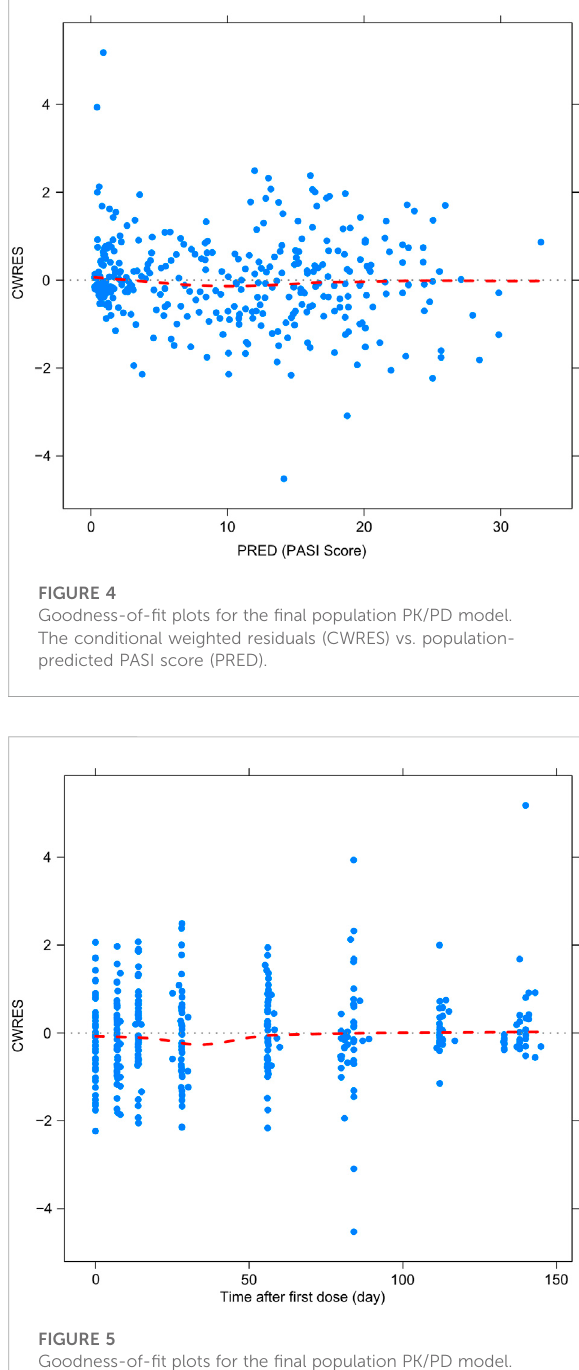
FIGURE 3 Goodness-of- fi t plots for the fi nal population PK/PD model. Observed PASI score (DV) vs. Population-predicted PASI score (PRED).